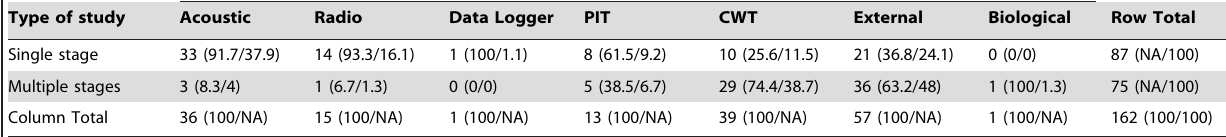
Table 3. Frequency (% within parentheses) of use of different tag types to study single and multiple life stages of anadromous salmonids in the marine environment for studies focusing on survival (i.e. those focusing on only survival and both on survival and behaviour).